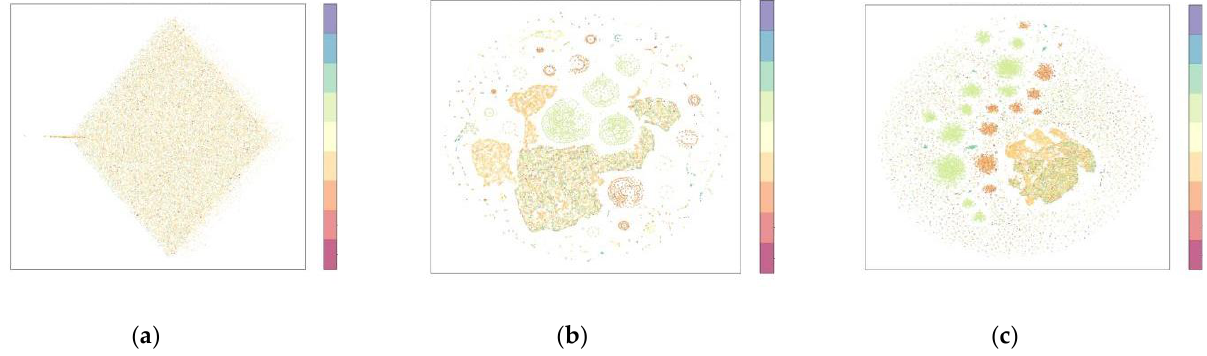
Figure 2. Visualization of data structure after dimensionality reduction by three different algorithms. ( a ) PCA algorithm. ( b ) T-SNE algorithm. ( c ) UMAP algorithm.